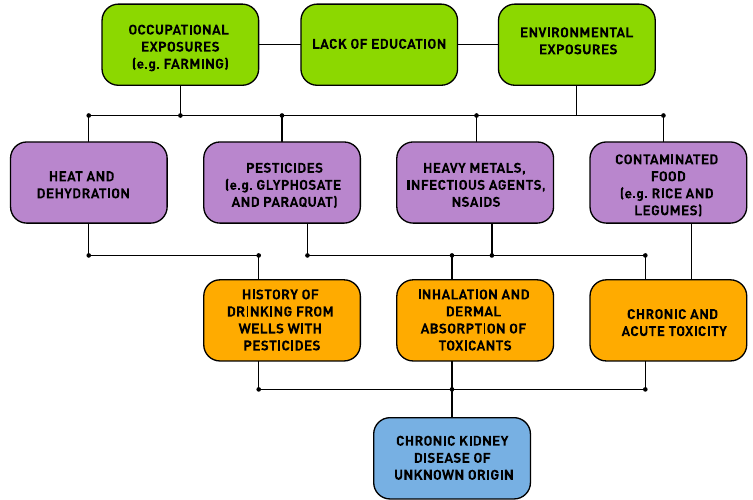
Figure 1. Web of causation of chronic kidney disease of unknown etiology (CKDu) in Sri Lanka.